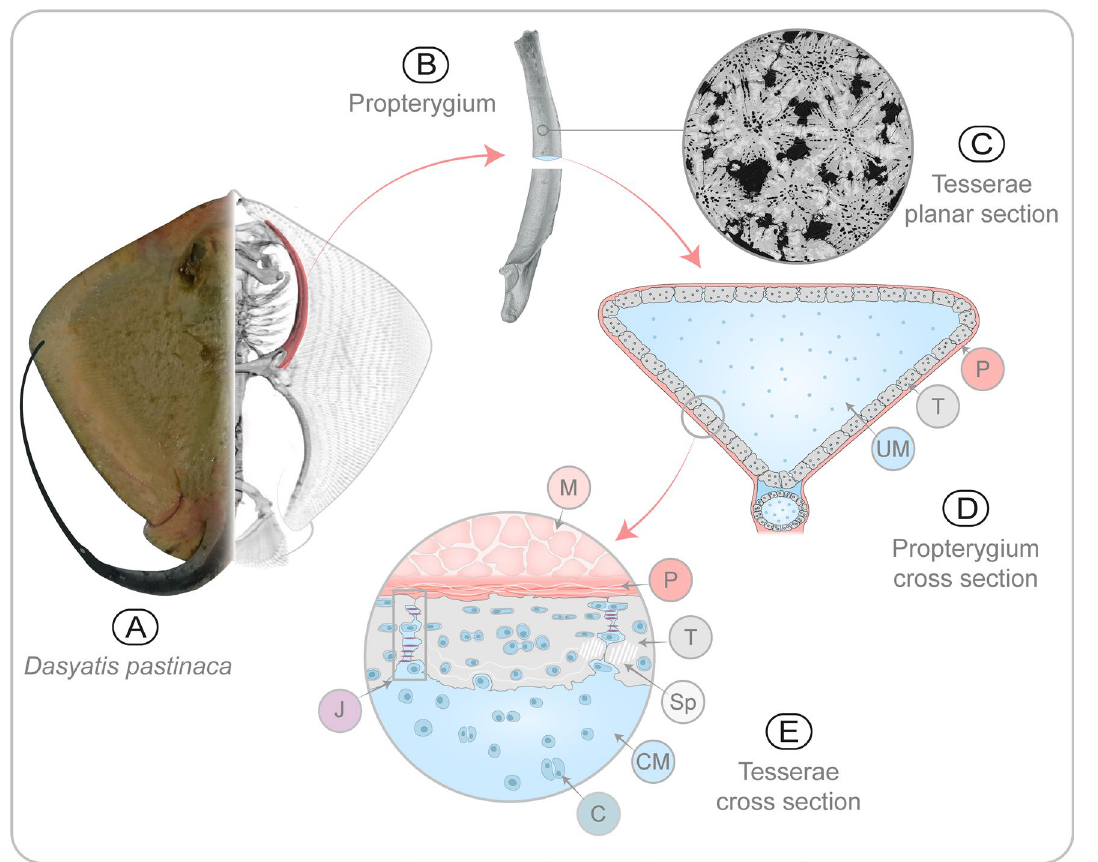
Fig. 1 Tessellated skeleton of sharks and rays (elasmobranchs). A Image of the common stingray Dasyatis pastinaca (left) and a microCT scan image of the skeleton (right), with the propterygium highlighted in red. B MicroCT scan of bisected propterygium, showing the inner car- tilaginous core (blue) surrounded by the tessellated layer (gray). C Backscatter Scanning Electron Microscopy (BSEM) image of a planar sec- tion through multiple tesserae, showing spokes (white streaks) and lacunae (black spaces) within tesserae. D Schema of the propterygium cross section from B , showing also the outermost perichondrium layer (red). E Schema of zoomed region in D , showing tesserae in vertical section, sandwiched between the perichondrial layer and the cartilaginous matrix. The single tessera in the center is connected to neigh- boring tesserae by a joint region (marked with a rectangle). Cells are located within tesserae, the cartilaginous matrix and joint regions. Chondrocytes (C), Cartilaginous matrix (CM), Joint (J), Muscle (M), Perichondrium (P), Spokes (Sp), Tesserae